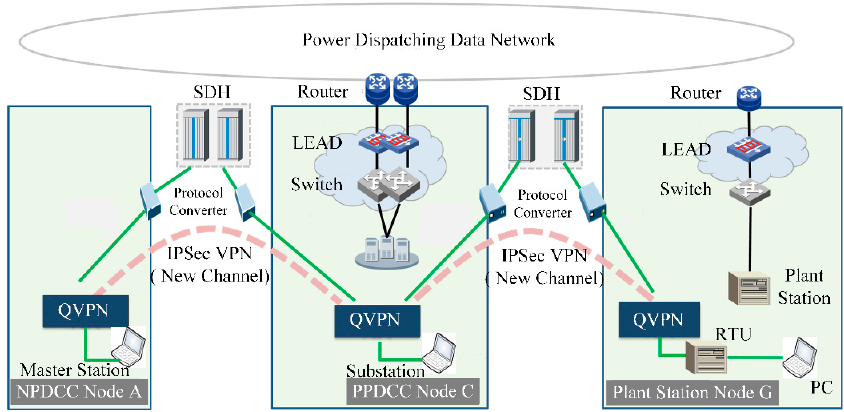
Figure 12. Schematic diagram of QKD-based dispatching automation test.